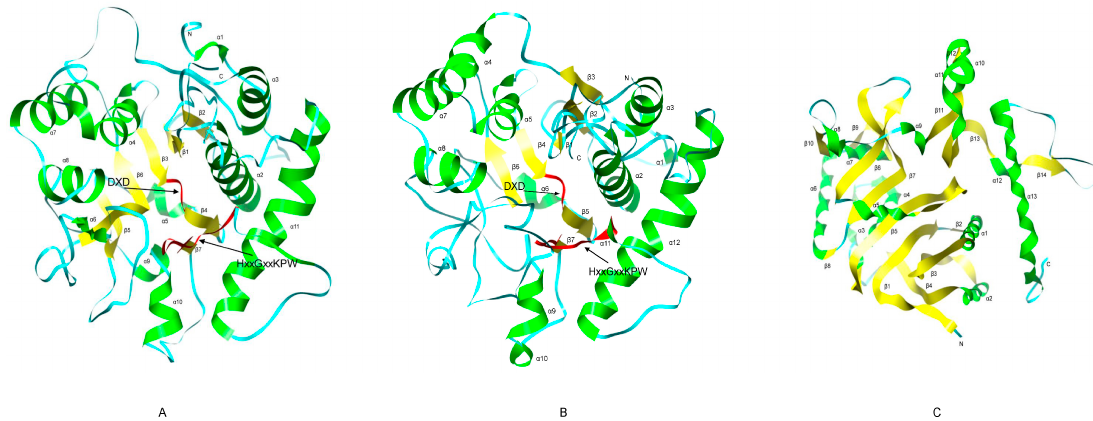
Figure 5. 3D Structure predictions for BnGolS and NtGolS. BnGolS1-2 and NtGolS1-1 were selected as the representative GolS proteins from B. napus and N. tabacum , respectively. The models were predicted by I-TASSER and the rabbit muscle glycogenin structure (PDB ID1ll0) was used as the template for the 3D structure predication. The conserved DXD and HxxGxxPW motifs are marked on the 3D structure in red. Green represents α -helices, yellow represents β -strands and navy blue represents random coils. ( A ) Modeled3D structure of BnGolS1-2; ( B ) Modeled 3D structure of NtGolS1-1; ( C ) Template model of 1ll0B. Structural images were generated with Chimera 1.2.